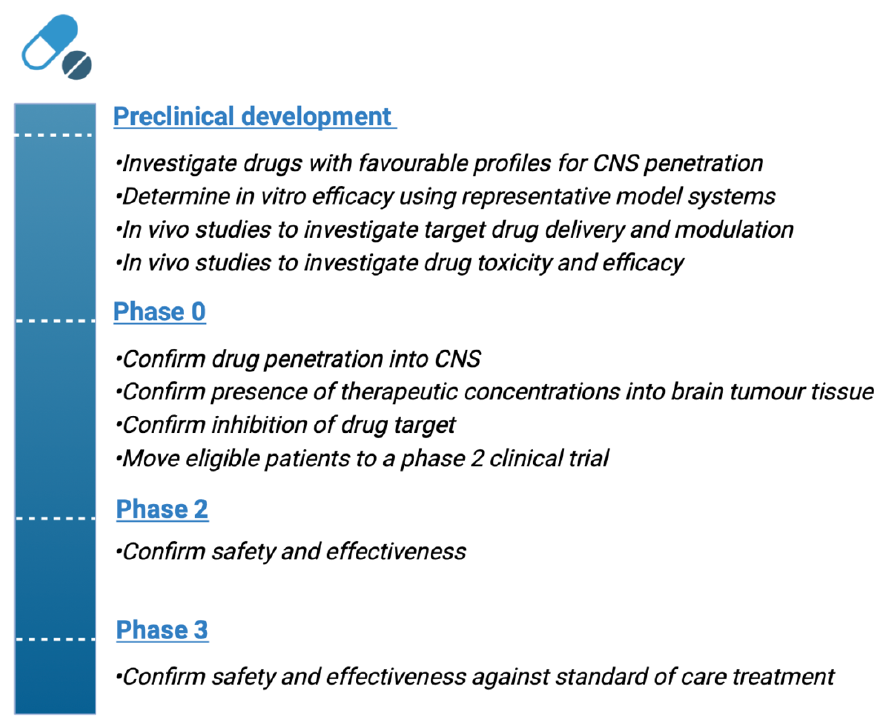
Figure 3. Development stages for repurposing a drug in glioblastoma.